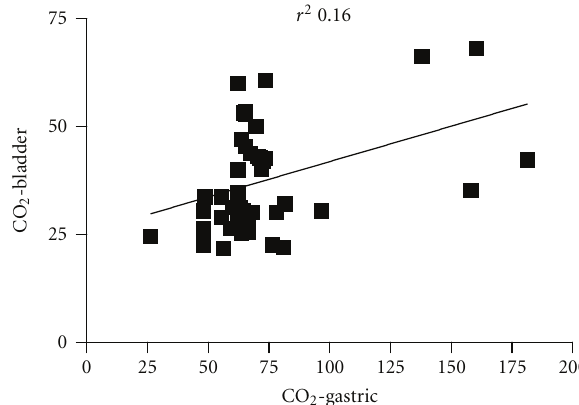
Figure 2: Relationship between gastric mucosal CO 2 and bladder mucosal CO 2